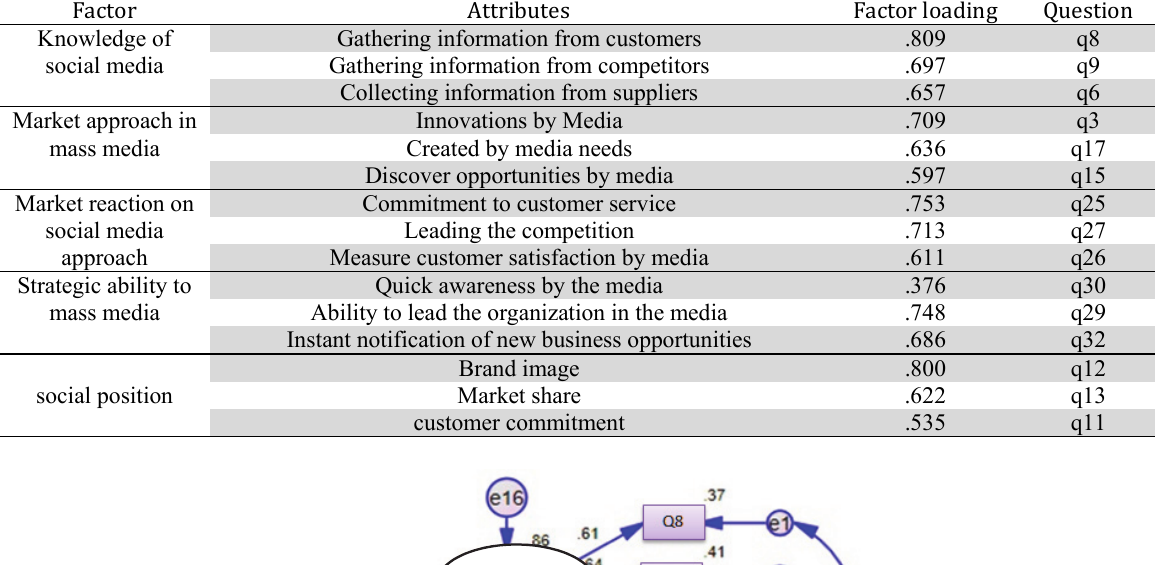
The results of the factors loading in terms of different categories